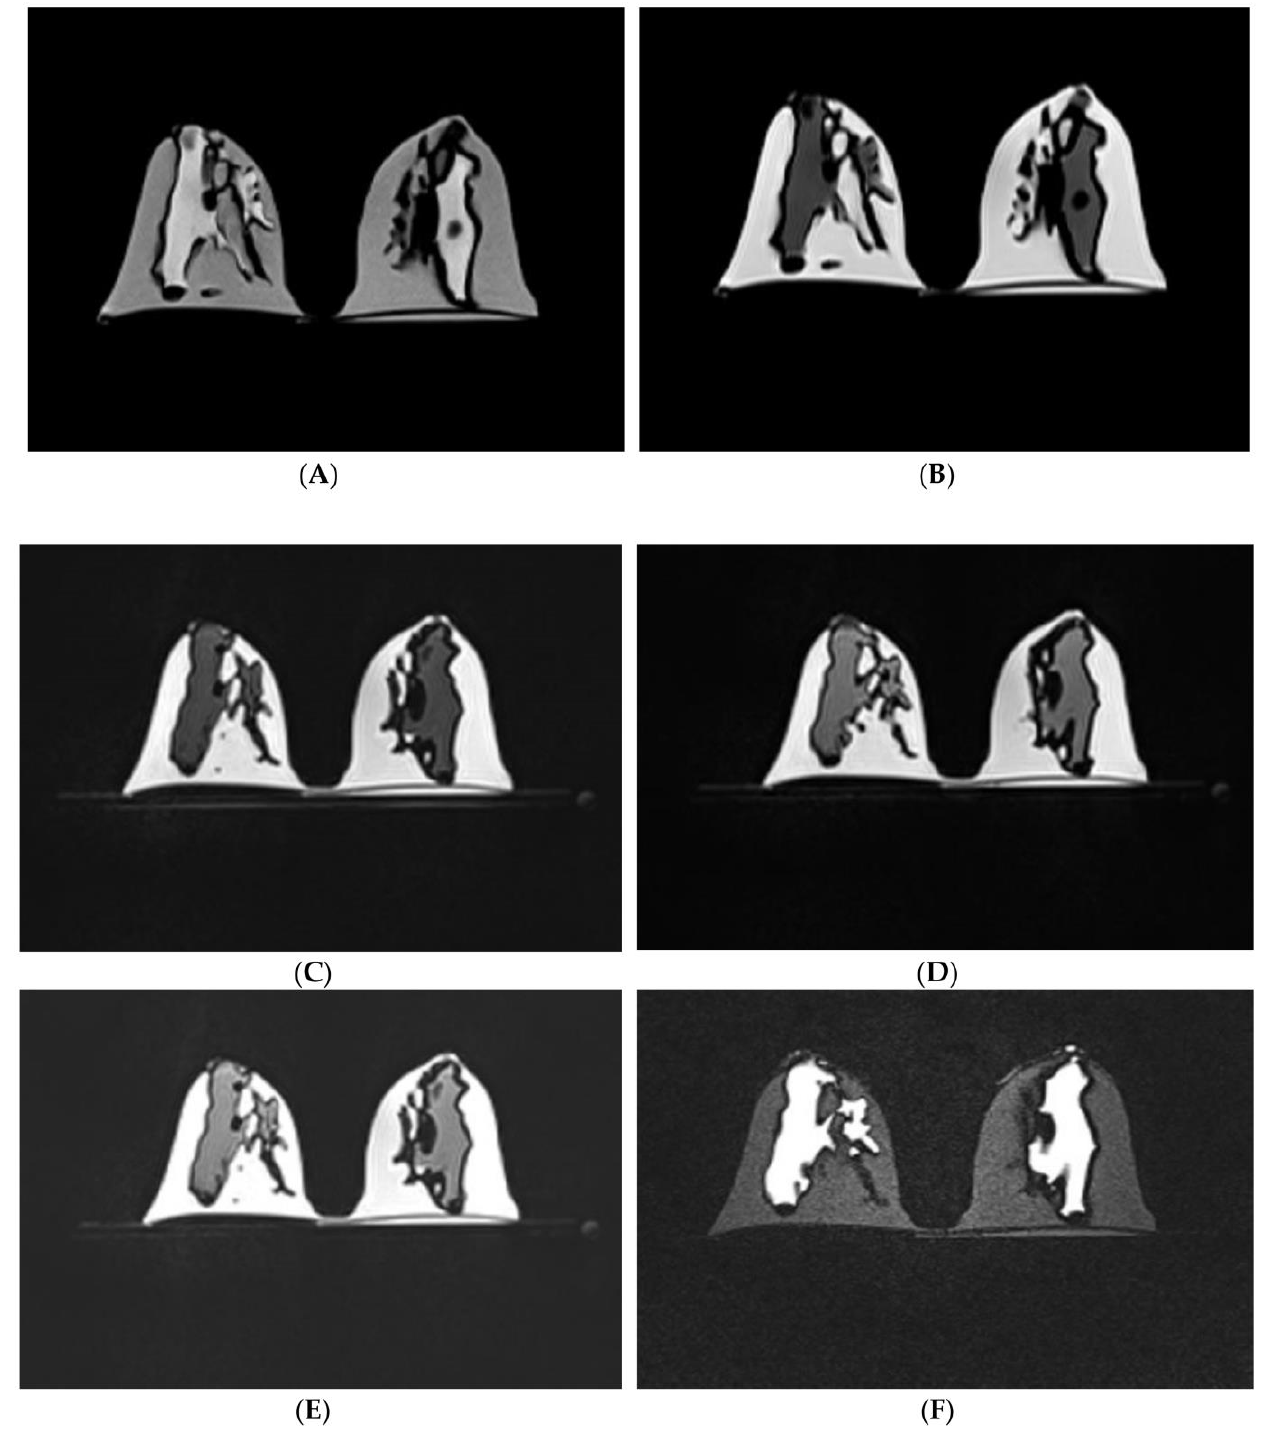
Figure 17. MR images of 3D-printed breast model with use of six different scanning sequences. ( A ) Non-fat-suppressed TSE (T2WI); ( B ) non-fat-suppressed TSE (T1WI); ( C ) non-fat-suppressed TSE SPACE (T1WI); ( D ) fat-suppressed TSE SPACE (T1WI); ( E ) fat-suppressed TSE SPACE SPAIR (T1WI); ( F ) fat-suppressed IR/PEF-TIRM (T2WI). T1WI—T1 weighted imaging, T2WI—T2 weighted imaging, TSE—turbo (fast) spin echo, SPACE—sampling perfection with application optimized contrast using different flip angle evolution, SPAIR—spectral attenuation inversion recovery, IR—inversion recovery, PFP—partial Fourier phase, TIRM—turbo inversion recovery magnitude. Reprinted with permission under the open access from Sindi et al.